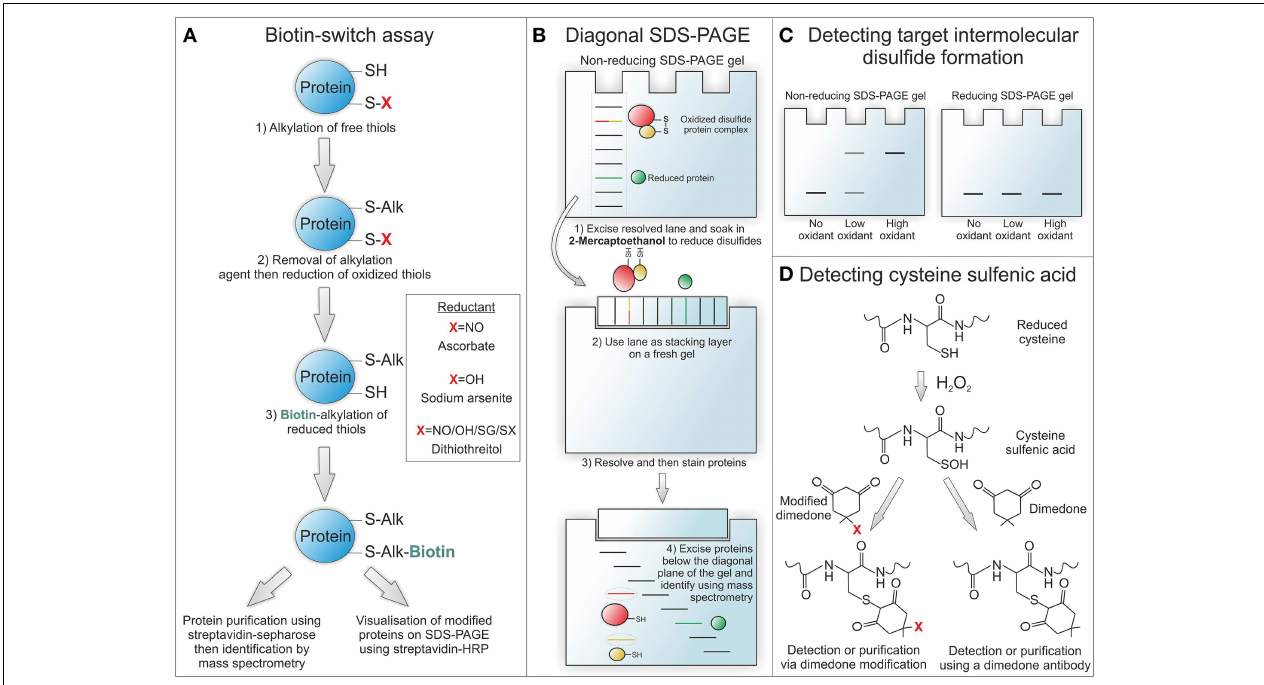
identified by excising and then analysing by mass spectrometry. (C) Proteins already known to form intermolecular disulfide bound complexes or identified by diagonal SDS-PAGE can be analyzed in cell or tissue samples for covalent complex formation by resolving under non-reducing conditions. By omitting the reducing agent disulfide bound complexes are preserved and can be detected as a higher molecular weight complex on immunostained blots. The formation of higher molecular weight complexes will increase under oxidizing conditions due to enhanced disulfide formation and will be reducible with 2-mecaptoethanol. (D) Cysteine sulfenic acids can be detected by the addition of dimedone, as it is able to selectively bind to this modification. Fluorescent or biotin derivates of dimedone can be used for detection or purification of sulfenic acid modified proteins. Alternatively a dimedone specific antibody can be used for detecting this compound when bound to protein sulfenic acids.